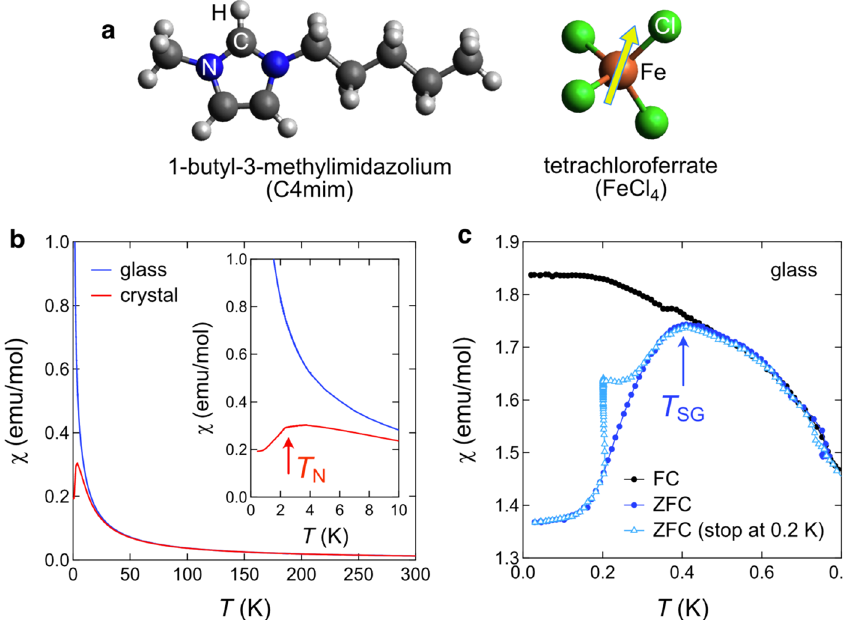
Figure 1. Magnetic properties of a magnetic ionic liquid (MIL). ( a ) Molecular structure of the MIL C4mimFeCl 4 , where the FeCl 4 − anion has a spin of 5/2. ( b ) Temperature dependence of magnetic susceptibility in glassy and crystalline C4mimFeCl 4 . Inset shows an enlarged plot below 10 K. ( c ) Zero-field-cooled (ZFC) and field-cooled (FC) susceptibilities in the glassy state on heating at T ≤ 0.8 K. Open triangles represent magnetization with an intermittent stop for 50 min at T = 0.2 K. The glassy sample displays a spin glass transition at T SG = 0.4 K, while the crystalline one exhibits an antiferromagnetic ordering at T N = 2.3 K. All the susceptibility data were obtained under an applied magnetic field of 100